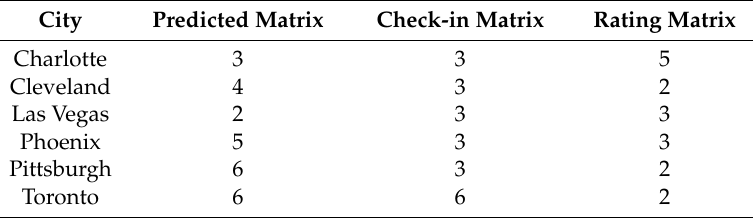
Figure 4. Eigen-gaps for different number of clusters and different matrices. Table 3. Selected number of clusters for different matrices and